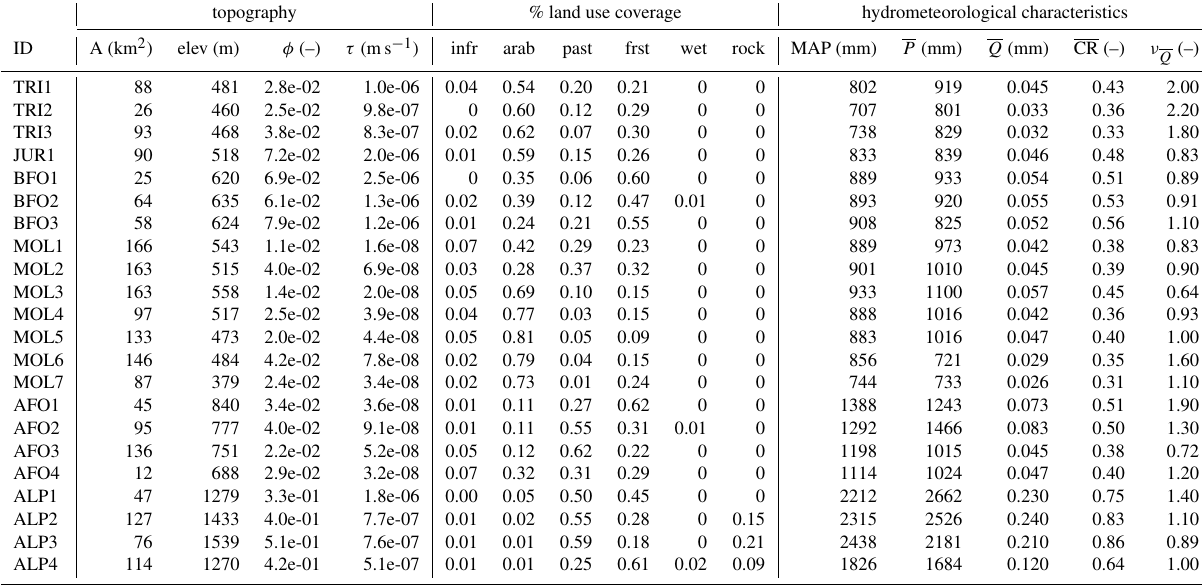
Table A1. Physiographic catchment properties in terms of topography, land use, and hydro-meteorology. The columns contain the site identifier (ID), catchment size (A), mean catchment elevation above sea level (elev), median topographic gradient ( φ ), soil topographic index ( τ ), relative land coverage ratios for infrastructure (infr), arable land (arab), pasture (past), forest (frst), wetlands (wet) and rock outcrops (rock), the 30-year mean annual precipitation (MAP), 4-year mean annual precipitation ( P ), discharge ( Q ), runoff coefficient (CR), and ) streamflow coefficient of variation (ν Q